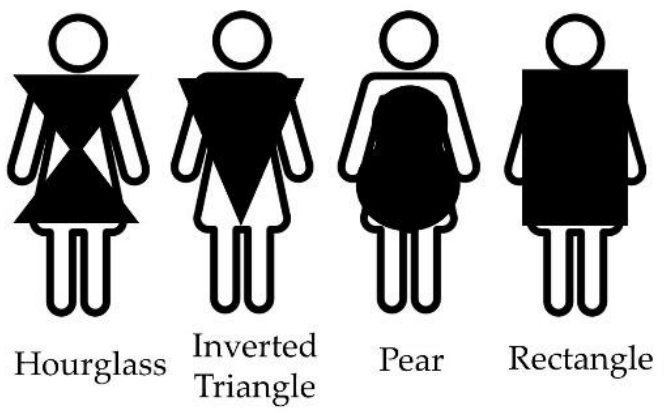
Figure 1. Four common body shapes for female.